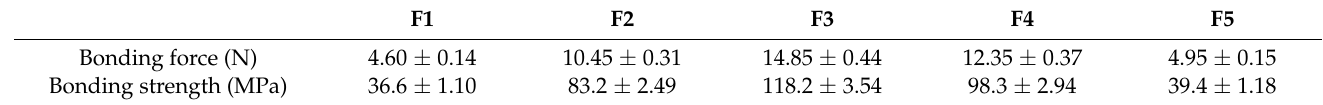
Figure 6. The bonding force of MAO coatings under different negative voltages. Table 5. The bonding force and load strength of MAO coatings under different negative voltages.